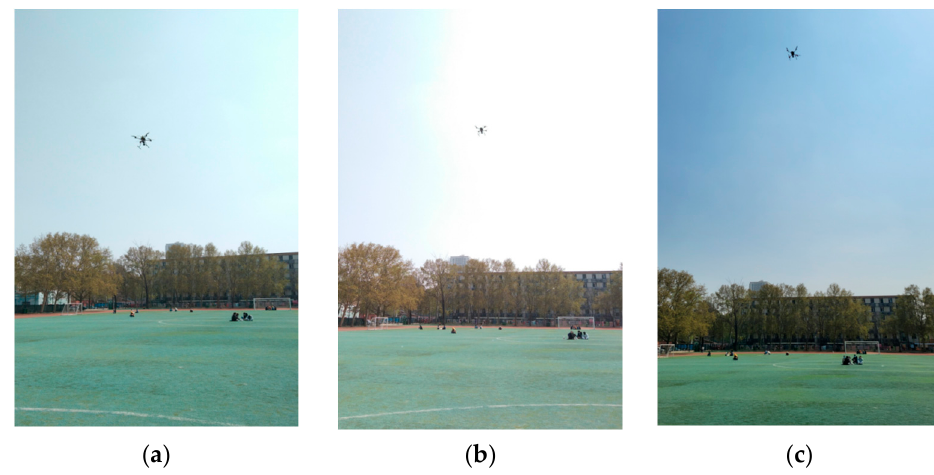
Figure 12. Flight measurements at different altitudes: ( a ) 5 m; ( b ) 10 m; ( c ) 15